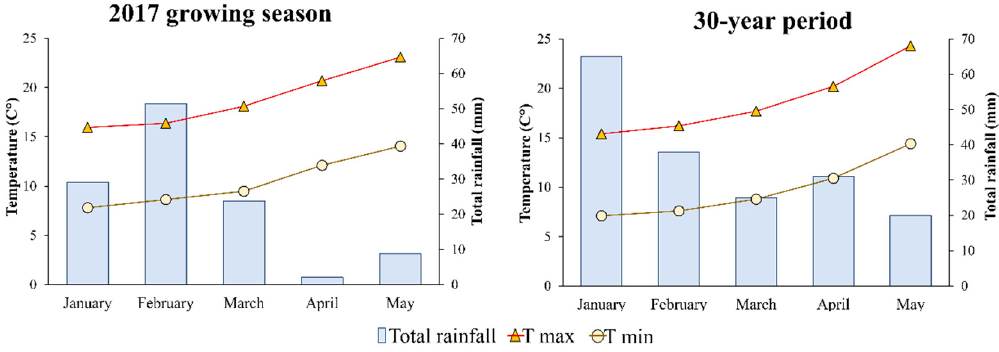
Figure 1. Total rainfall and average monthly maxima and minima temperatures for the 2017 growing season and long-term period (1977–2006).